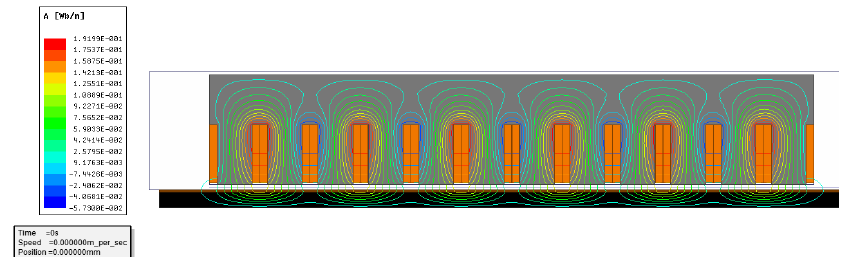
Figure 4. Distribution field diagram of the static magnetic line.